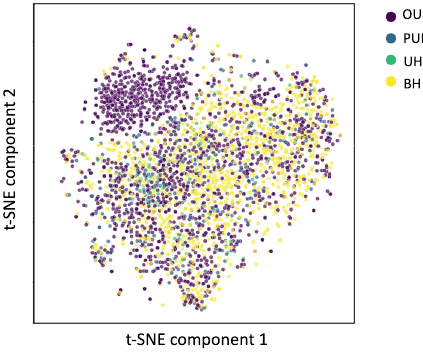
Fig. 1 t-Stochastic Neighbor Embedding (t-SNE) visualization of data. Figure shows t-SNE representation of datasets used in